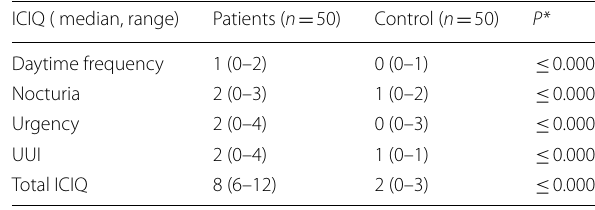
Table 4 Discrimination properties of the Arabic ICIQ between patients with BOO with OAB‑like symptoms (BOO group)